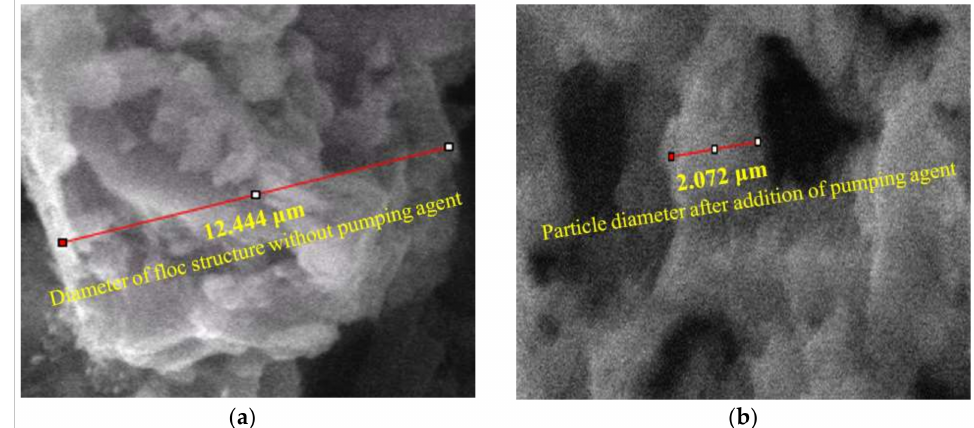
Figure 10. Particle diameter measurement: ( a ) diameter of typical floc structure without pumping agent; ( b ) particle diameter after the addition of pumping agent.